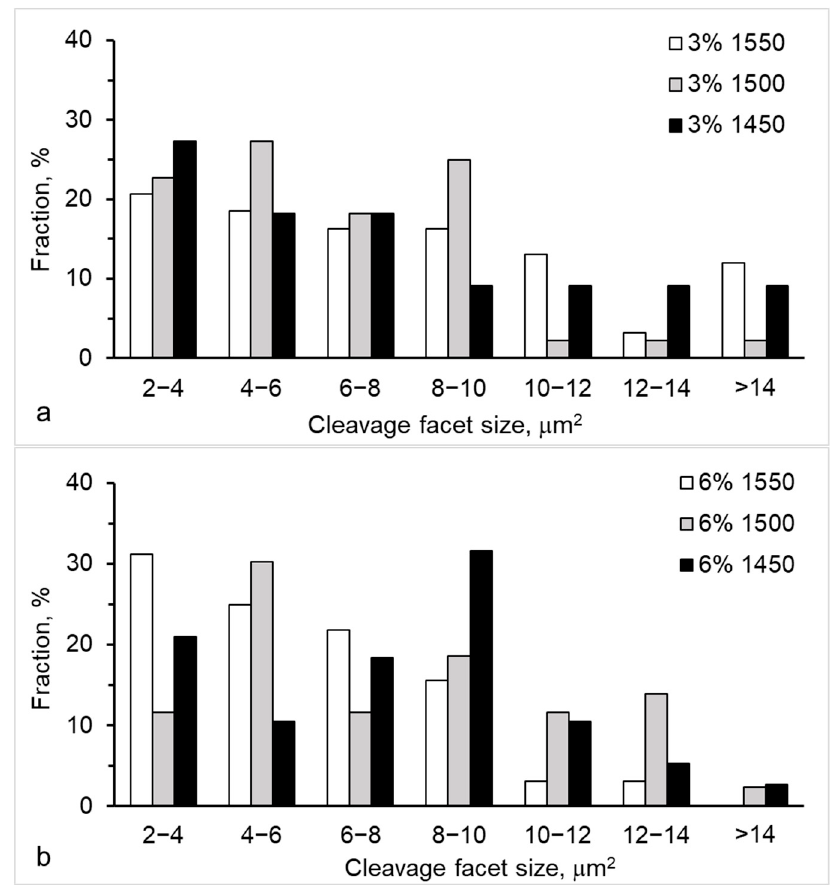
Figure 10. Cleavage facet size distributions for ( a ) 3YSZ and ( b ) 6YSZ ceramics sintered at three temperatures.